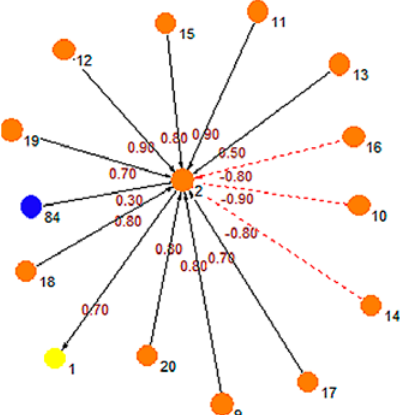
Fig. 4. Quantification of relationships